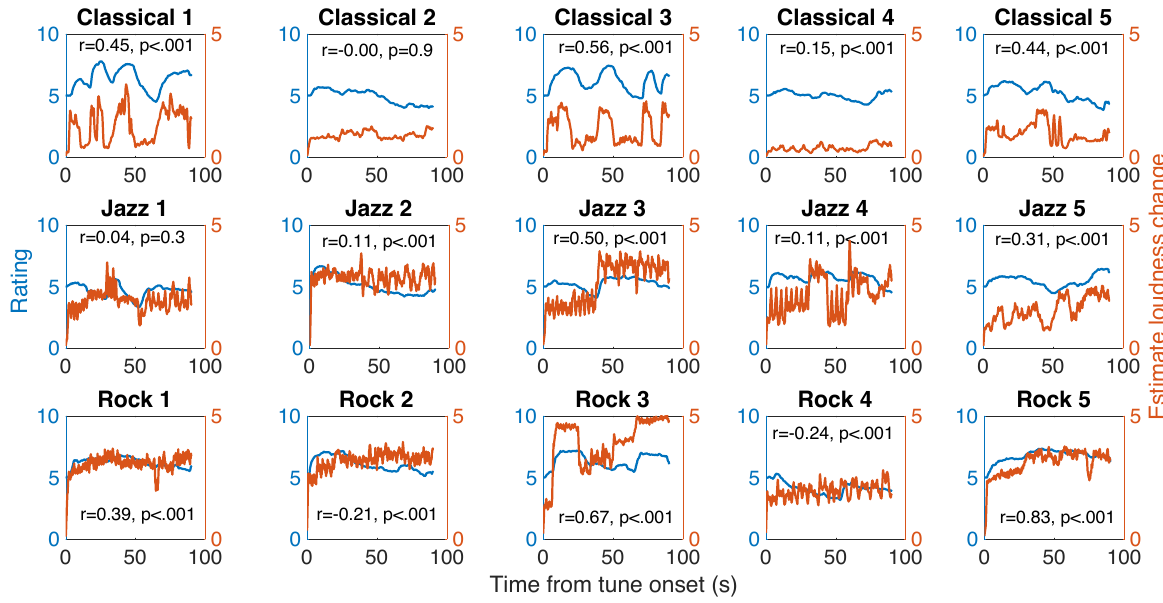
Fig. 7. Subjective salience rating (blue lines) and estimated instantaneous loudness change (orange lines) over time. Pearson’s correlation coefficients with hypothesis testing p-values are shown for each